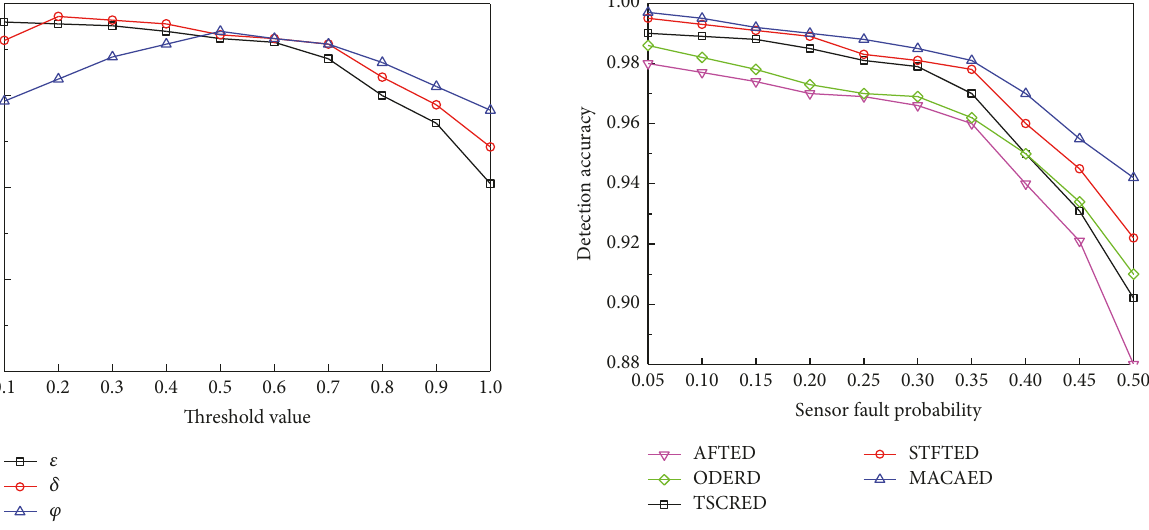
Figure 6: Detection accuracy of five algorithms.